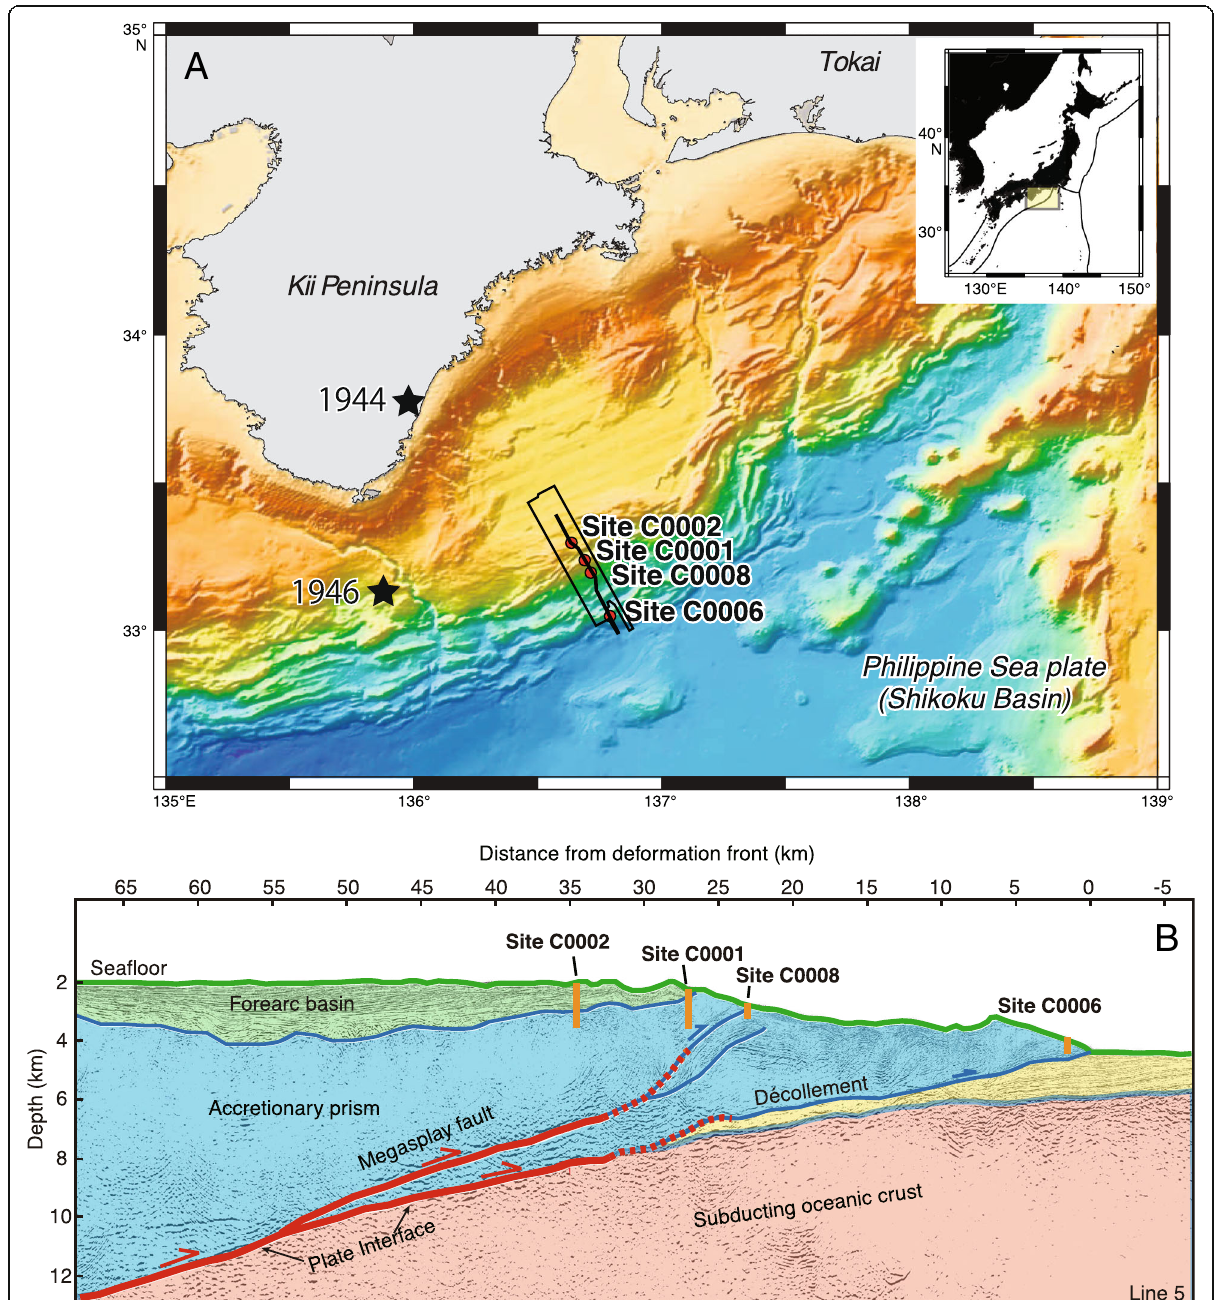
Fig. 1 Location of drilling sites C0001, C0002, C0006, and C0008 along the NanTroSEIZE (Nankai Trough Seismogenic Zone Experiment) transect for investigated samples and fault slip data. a Map off Kii Peninsula and offshore bathymetry; epicenters of the 1944 and 1946 earthquakes are indicated (stars). The inset shows the location of this map area offshore SW Japan. b Seismic profile with geological interpretation following the NanTroSEIZE transect in A (after Park et al.